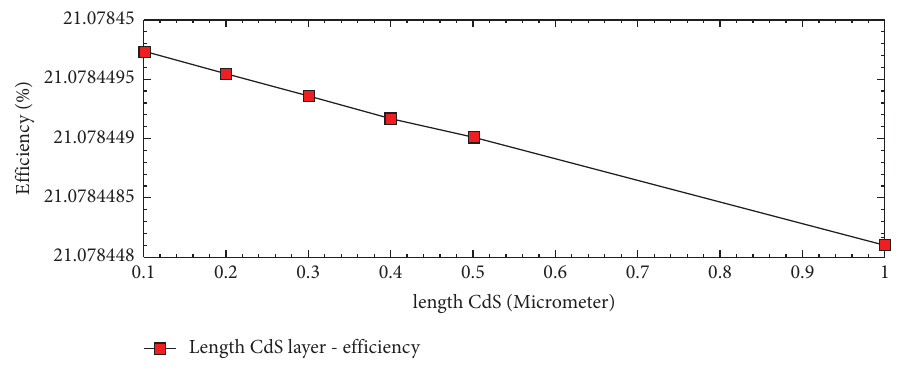
Figure 3: Performance diagram in terms of SnO